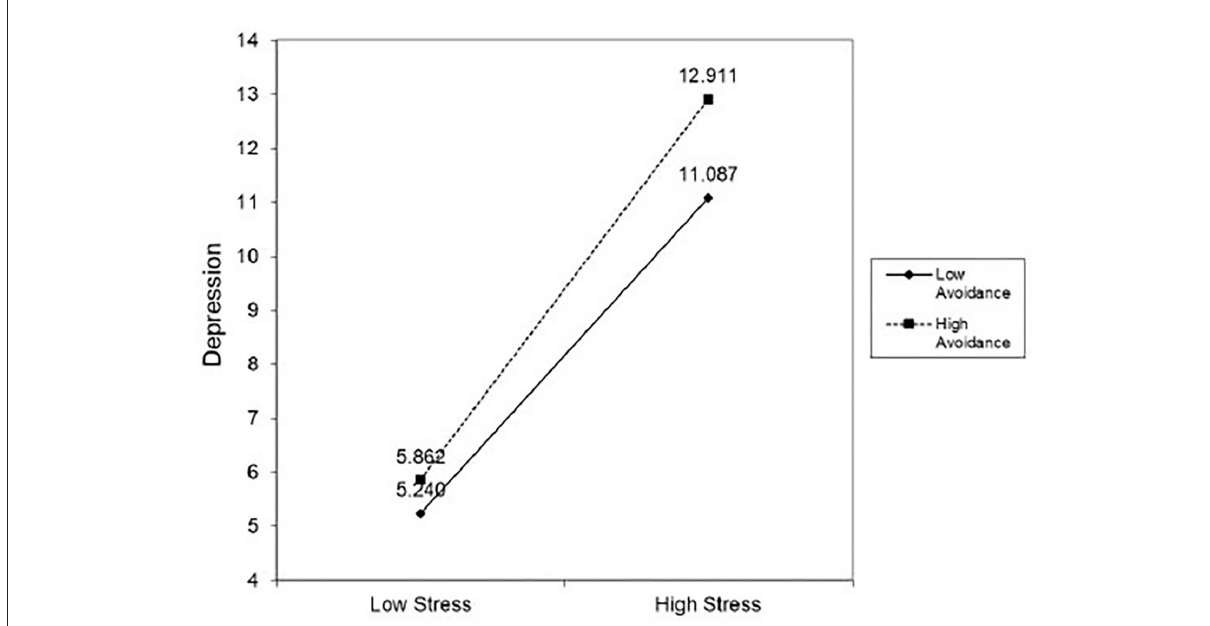
FIGURE2 The moderating effect of avoidant coping on the relationships between job stress and